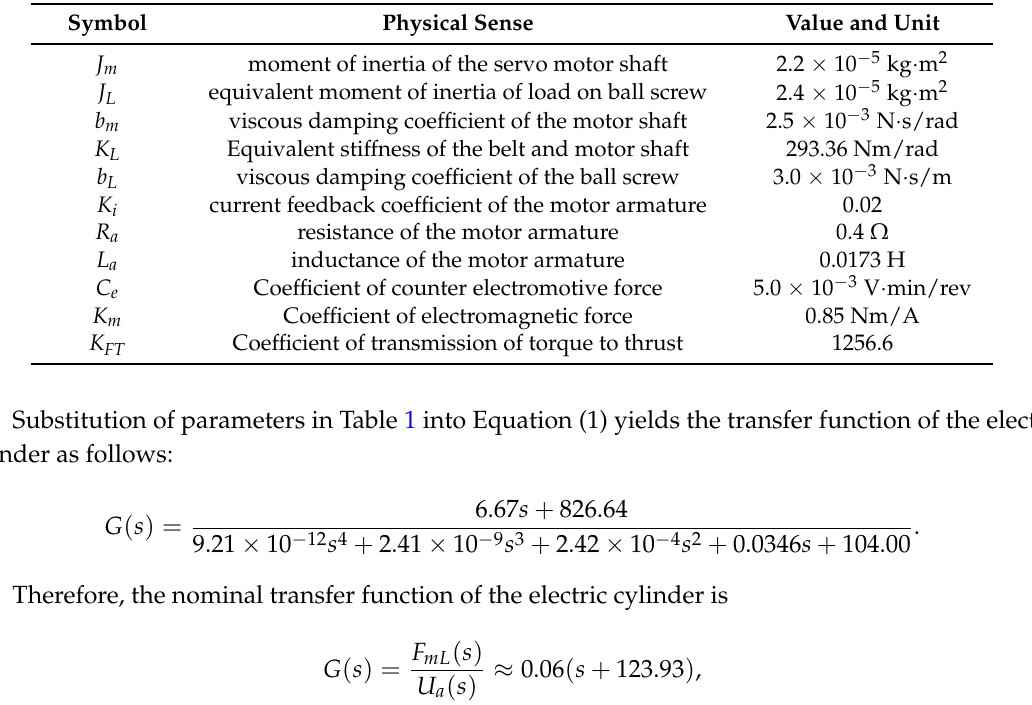
Table 1. Specification parameters of the electric